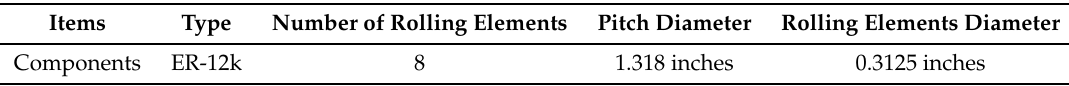
Figure 2. Multi-function mechanical fault simulator: (1) AC motor, (2) sensor, (3) shaft, (4) rotor disc, (5) test bearing, (6) outboard bearing housing, (7) normal bearing, (8) inboard bearing housing, (9) flexible coupling, (10) converter. Table 1. Some key technical characteristics of used